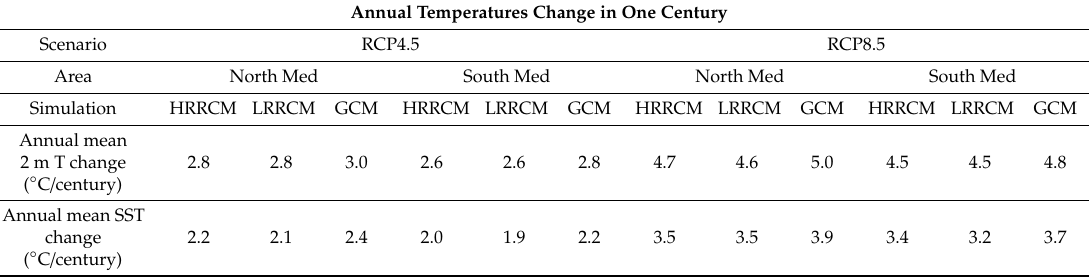
Table 1. Rate of change of the annual mean 2 m temperature and of the sea surface temperature in one century ( ◦ C / century). Values represent averages over the north and south Mediterranean areas for the two emission scenarios (RCP4.5 and RCP8.5) and for each horizontal grid resolution HRRCM, LRRCM and GCM. The whole period 1960–2100 is considered for computing the trend.